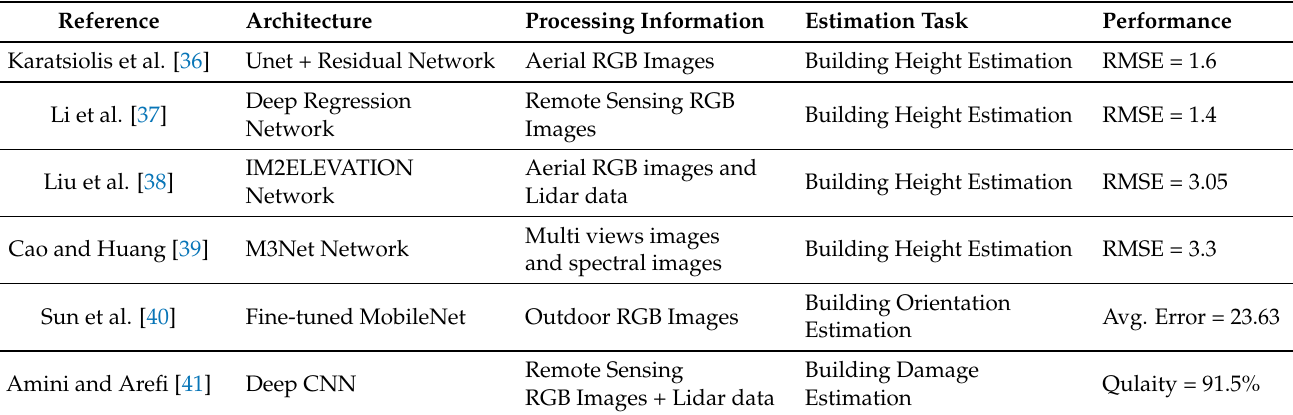
Table 1. Various studies for building characteristics estimation in the